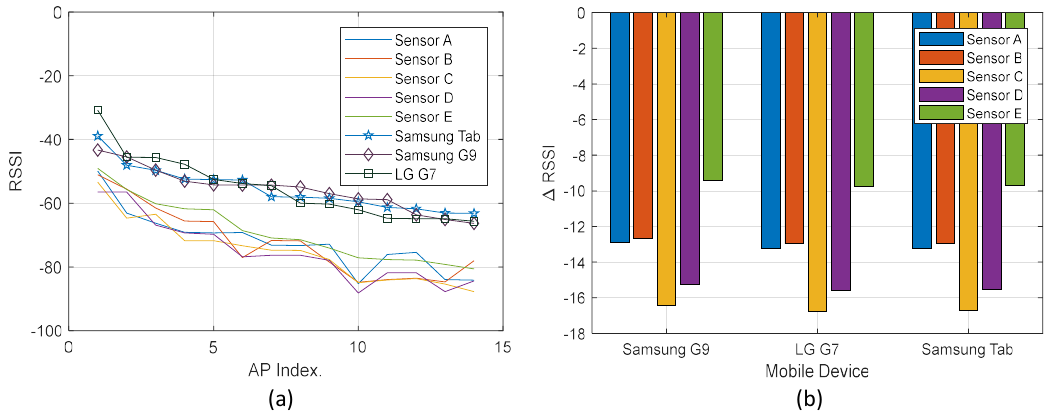
Figure 4. Calibration of Wi-Fi sensors. ( a ) Signal strength received from devices for the number of access points. ( b ) Signal difference in sensor power reception compared to mobile